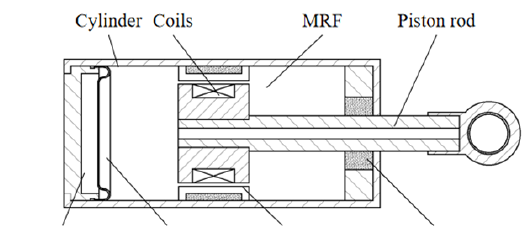
Figure 1. Structure of a typical internal MRD.